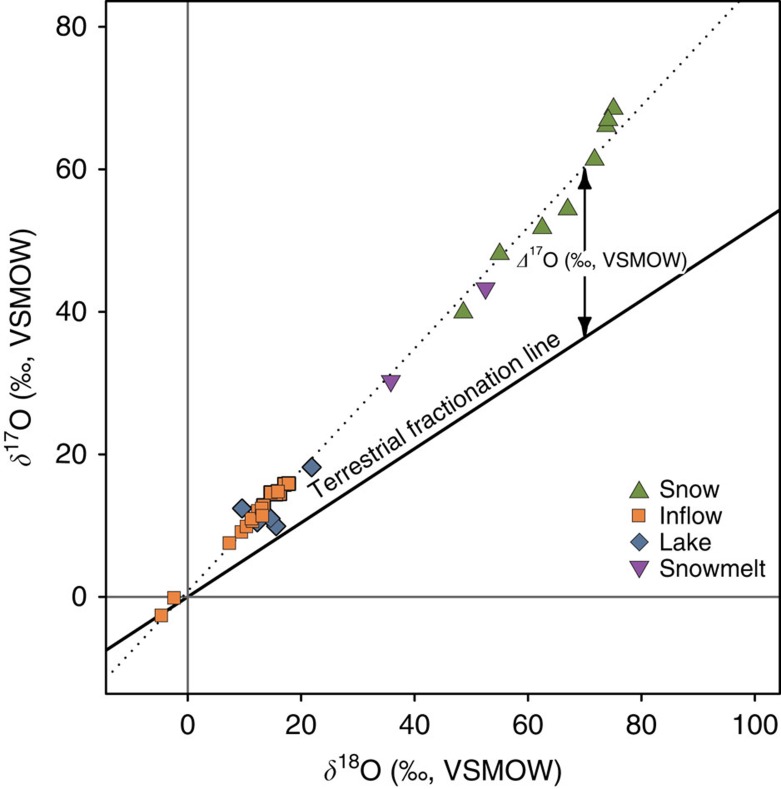
δ17O- versus δ18O-NO3− of Uinta Mountain water samples compared with the terrestrial fractionation line.Δ17O is the difference between the measured δ17O and the δ17O expected based on the terrestrial fractionation line (δ17O=0.52 × δ18O)56.